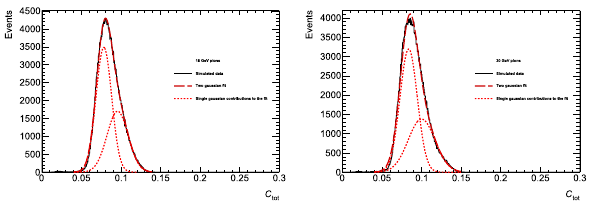
Fig. 11 The black histograms show C tot distributions obtained using simulated pions with E beam equal to 18 GeV ( a ) and 30 GeV ( b ). The events were selected requiring C long ≥ 0.6. Two Gaussian functions fits, obtained using the method of the least squares, are superimposed on the data (red dashed curve). Red dotted curves show the individual Gaussian contributions